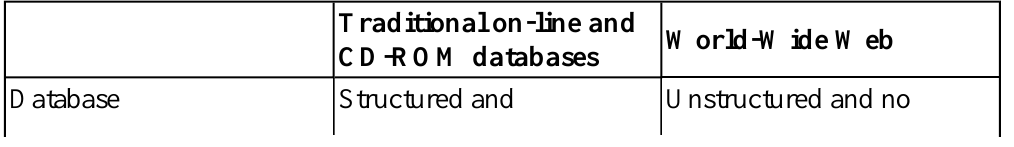
Table 1 Comparison of search